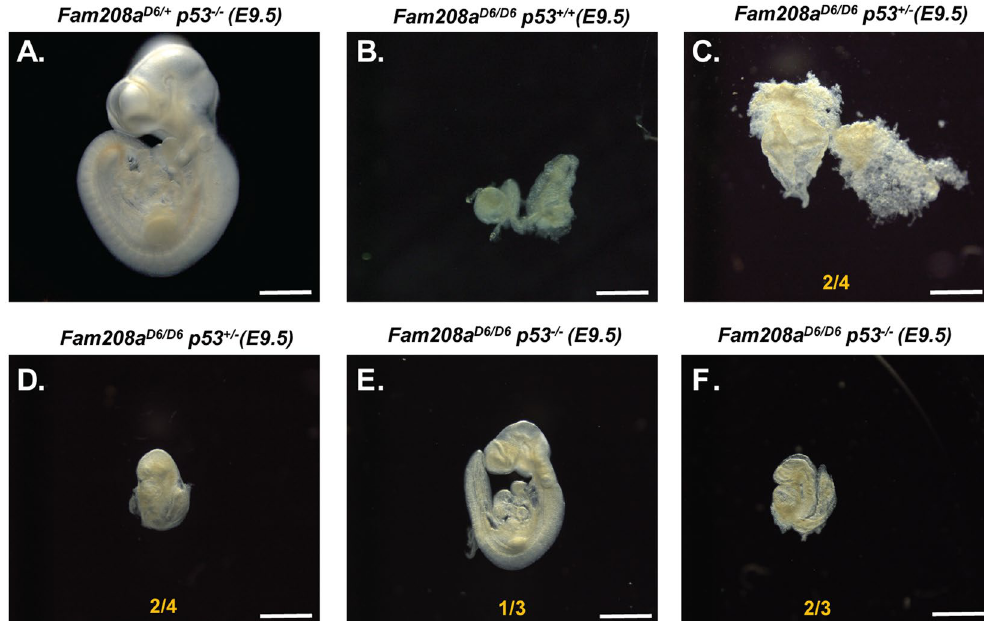
Figure 6. Partial rescue of Fam208a D6/D6 mutant gastrulation block upon p53 removal. Gross morphology of E9.5 embryos obtained from Fam208a ; + /D6 p53 + / − intercrosses. ( A ) Representative bright-field image of normally developing Fam208a ; + / + p53 − / − control embryos, ( B ) no rescue of the Fam208a D6/D6 phenotype is observed as a result of the introduced mixed background (FVB/N and C57BL/6 J), however variable rescue of the Fam208a D6/D6 phenotype is observed in embryos with p53 + / − ( C,D ) or p53 − / − ( E,F ) genotypes. In all cases, representative embryos of each genotype are shown. Scale bar: 100 µ